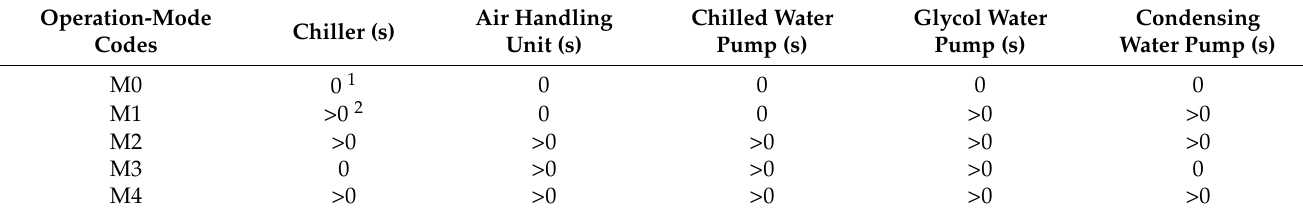
Table 3. Energy-consumption types of devices for different operation